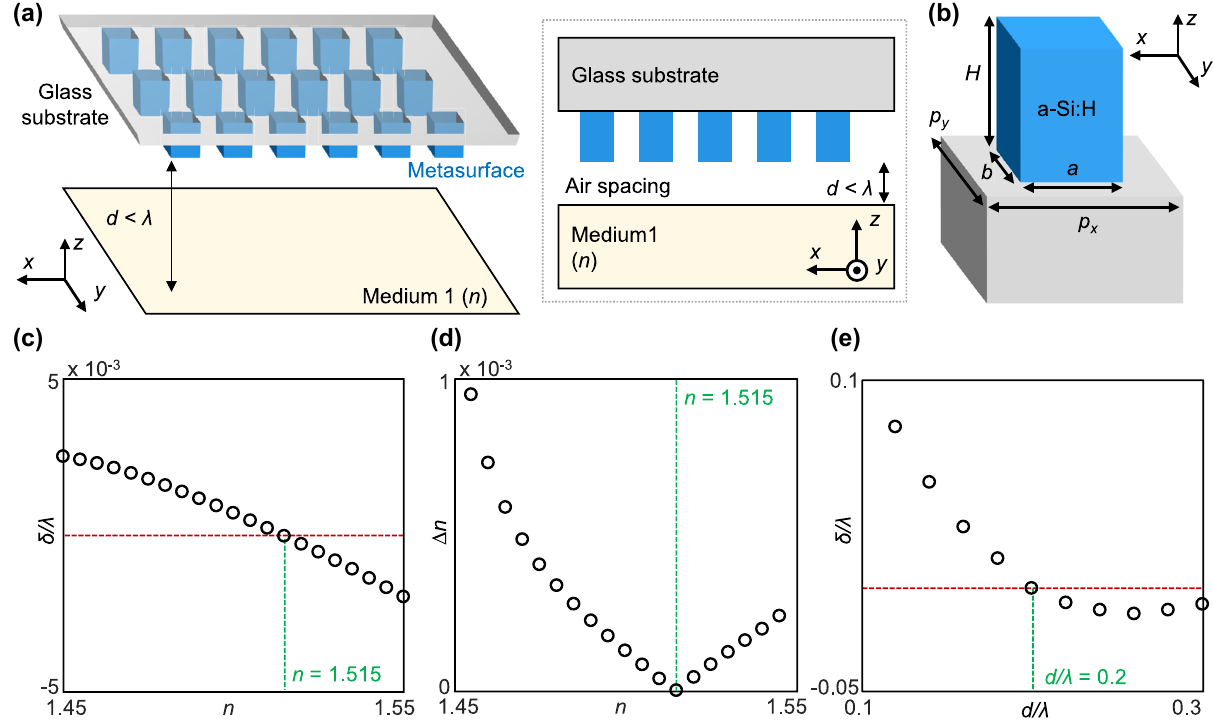
Figure 4: Precision enhancement using a metasurface. (a) Schematic of metasurface placed near target interface. Inset: the same schematic in the z – x plane. (b) Unit cell of the metasurface. Geometric parameters are given as: a = 268, b = 354, H = 371, p nm. The rod is made of hydrogenated amorphous silicon (a-Si: H). The incident plane is the z – x plane. (c) Spin Hall shift and (d) corresponding index resolution for various values of n when d = 0.2 𝜆 . (e) Spin Hall shift for various d values when n = 1.515. The green lines = 25 ◦ represent 𝛿 = 0. In all cases, 𝜃 I